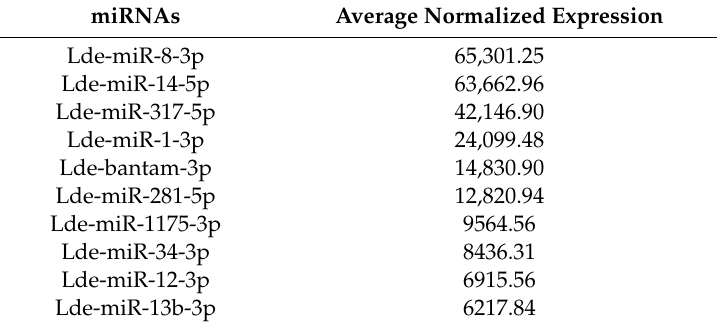
Table 4. Strongly expressed miRNAs in L. decemlineata as determined by high-throughput sequencing. Results shown are average normalized expressions for all samples.